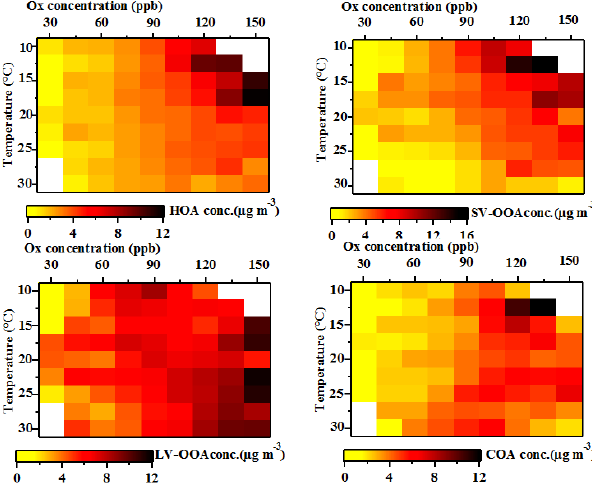
Table 1. Average concentrations of NR-PM 1 and OA components